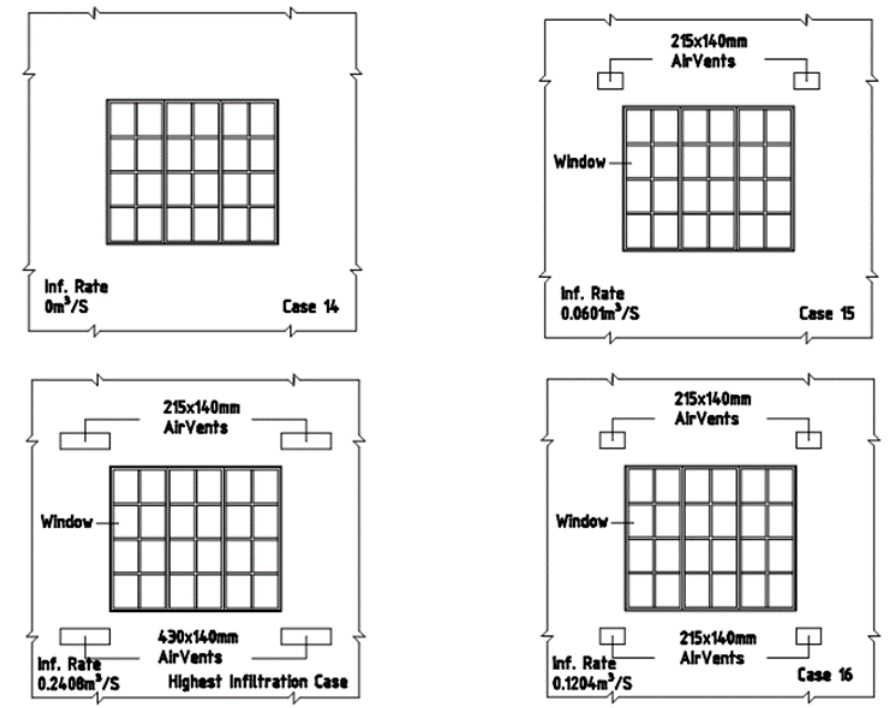
Figure A5. Air vents infiltration configuration.